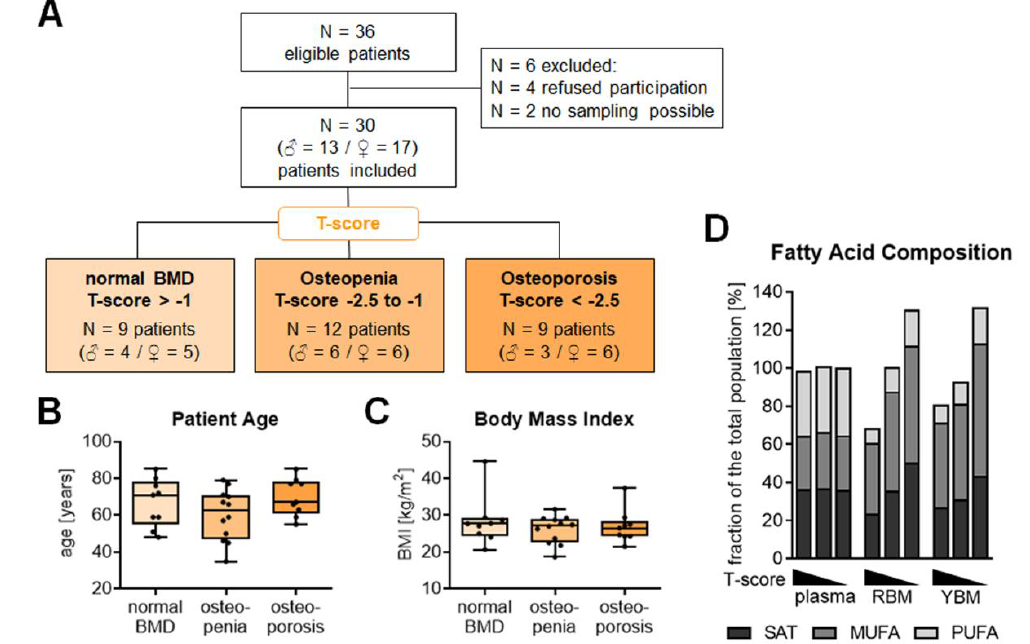
Figure 1: Overview of the patients analyzed in this study. ( A ) CONSORT diagram summarizing the patients included in this study. N = 30 patients were included in the study, which got grouped into three groups based on their age-adjusted bone mineral density (T-score). Summary of the ( B ) age and ( C ) body mass index (BMI) of the included patients. Data are summarized as box plots with individual data points. Groups were compared with non-parametric Kruskal-Wallis test, followed by Dunn’s multiple comparison test. Between the three groups, no significant ( p < 0.05) difference in the patients’ age and BMI was detected. ( D ) The composition of saturated fatty acids (SAT), mono-unsaturated fatty acids (MUFA), and poly-unsaturated fatty acids (PUFA) in the plasma, red bone marrow (RBM), and yellow bone marrow (YBM) is summarized as stacked bars. The total amount of fatty acids is presented as % of the average amount of all 30 samples